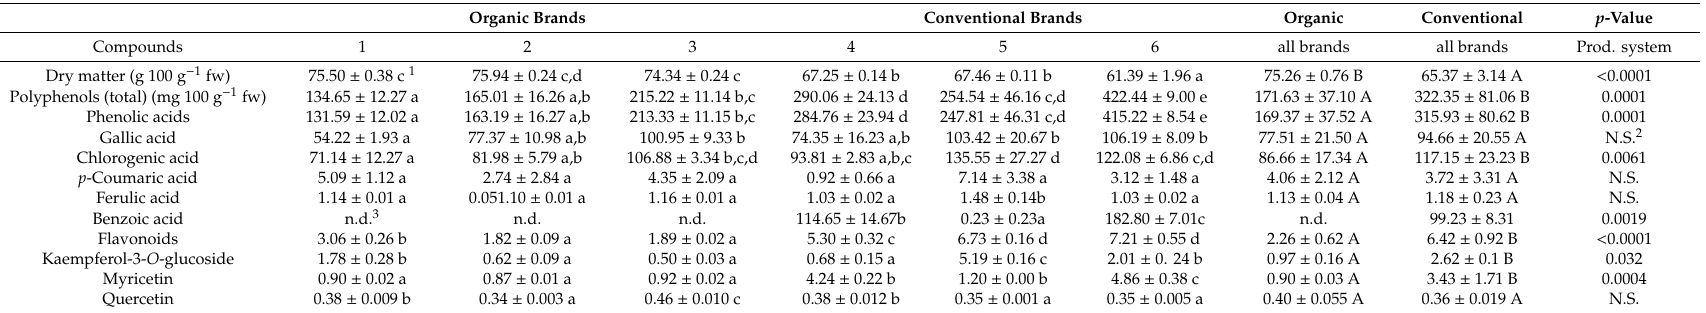
Table 4. The content of dry matter and selected phenolic compounds in prunes of organic and conventional brands available on the Polish market. Organic Brands Conventional Brands Organic Conventional p